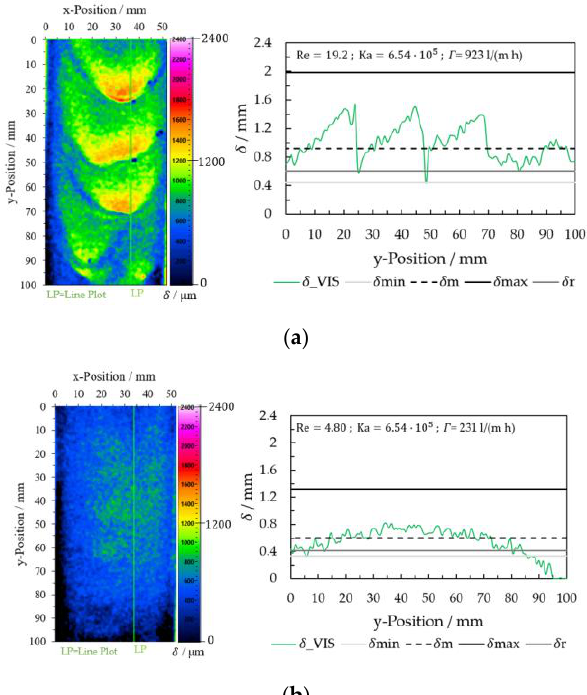
Figure 11. Film thickness determination using VIS image analysis for the glycerol/water mixture 0.65 g glyc g total − 1 ( a ) Re = 19.2 and ( b ) Re = 4.80.